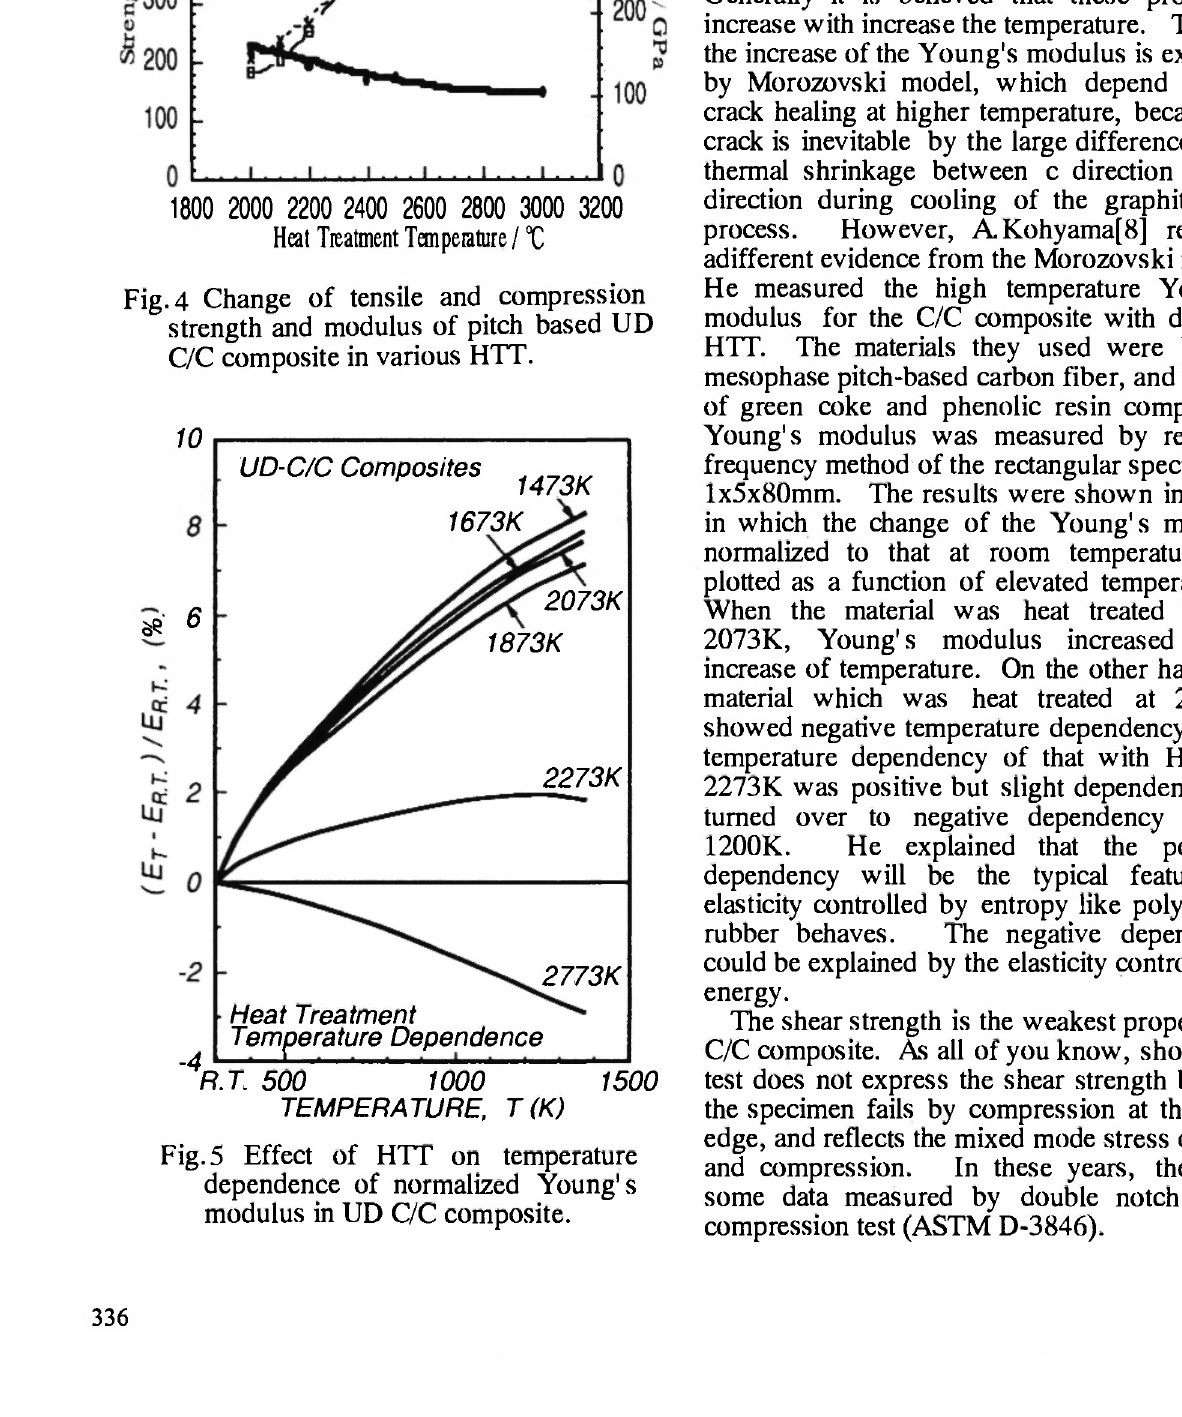
Fig. 4 Change of tensile and compression strength and modulus of pitch based UD C/C composite in various HTT.